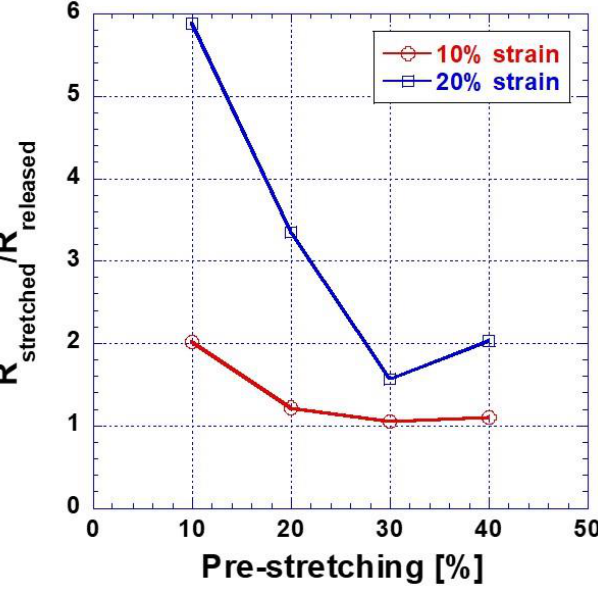
Figure 5. The change of ratio R stretched /R released with pre-stretching of silicone rubber (R stretched : the resistance of Ag NWs electrode when film was stretched; R released : the resistance of Ag NWs electrode when film was released).